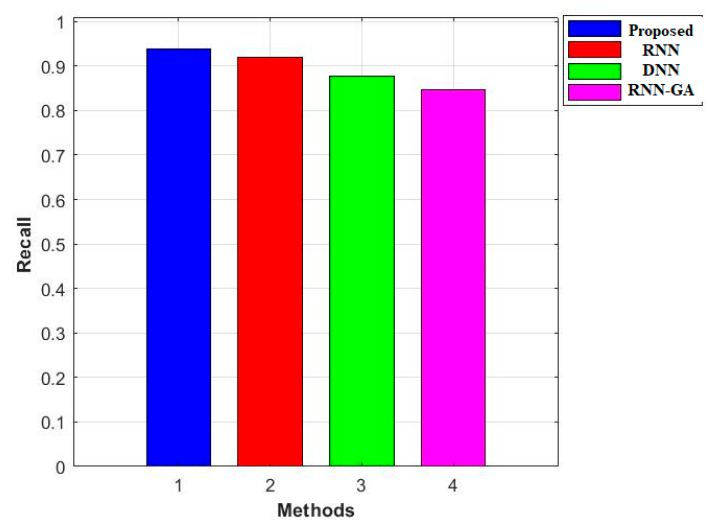
Figure 11. Recall performance of confusion matrices.